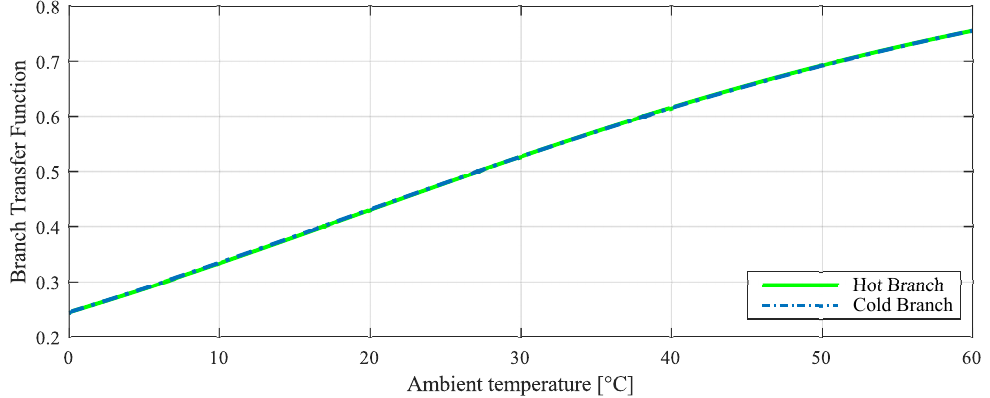
Figure 6. Transfer function of hot and cold branches in the CTD Wheatstone bridge.